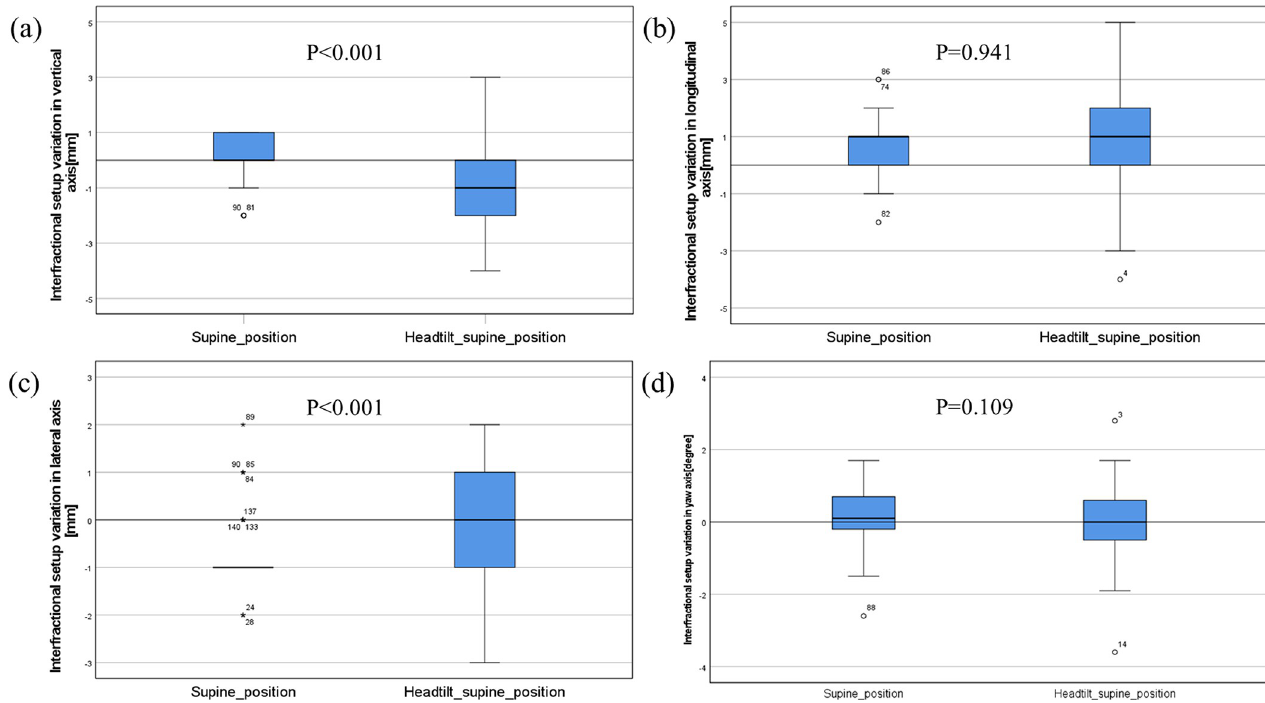
Fig 6. Boxplot and p -value of the Mann–Whitney U-test in the translation and rotation be-tween the c-SP and ht-SP. Setup errors in the (A) lateral, (B) longitudinal, (C) vertical, and (D) yaw directions.